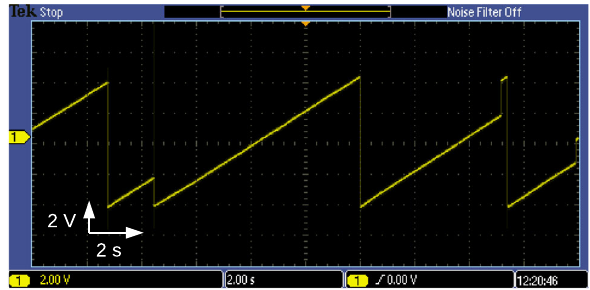
Fig. 8 Exemplary baseline from the pulsed-reset preamplifier of the C4 detector inside the Conus shield at KBR. The dynamic range goes up to ≈ 8V, while the time interval between two resets can be large, i.e. up to ≈ 8s